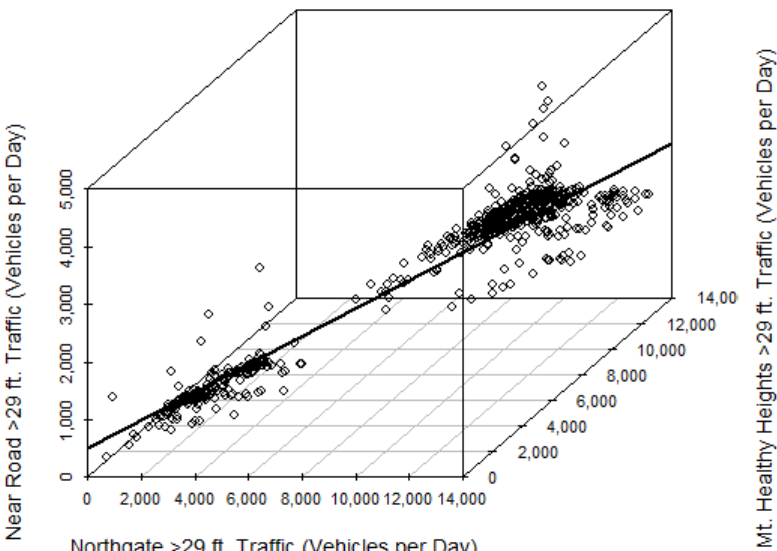
Figure 6. Results of using Northgate and Mt. Healthy >29 ft traffic counts to predict Near Road >29 ft traffic counts via linear regression. The regression equation, p -value for fit of predictor, and R 2 are shown in the top left of the figure. The two clusters of data seen are representative of weekend vs. weekday traffic volumes (see Figures S2–S4).